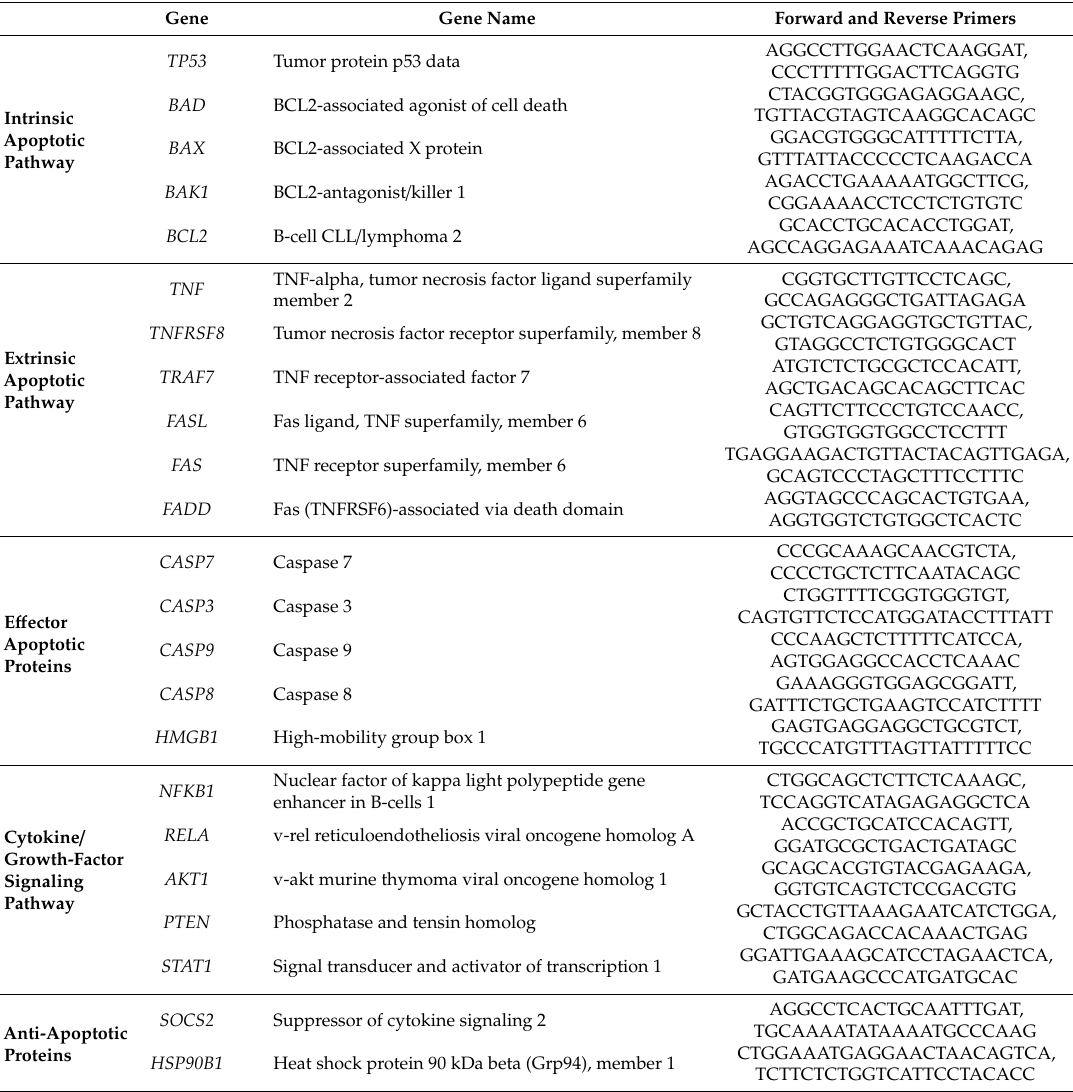
Table 3. The apoptosis-related genes investigated and the primers used in this